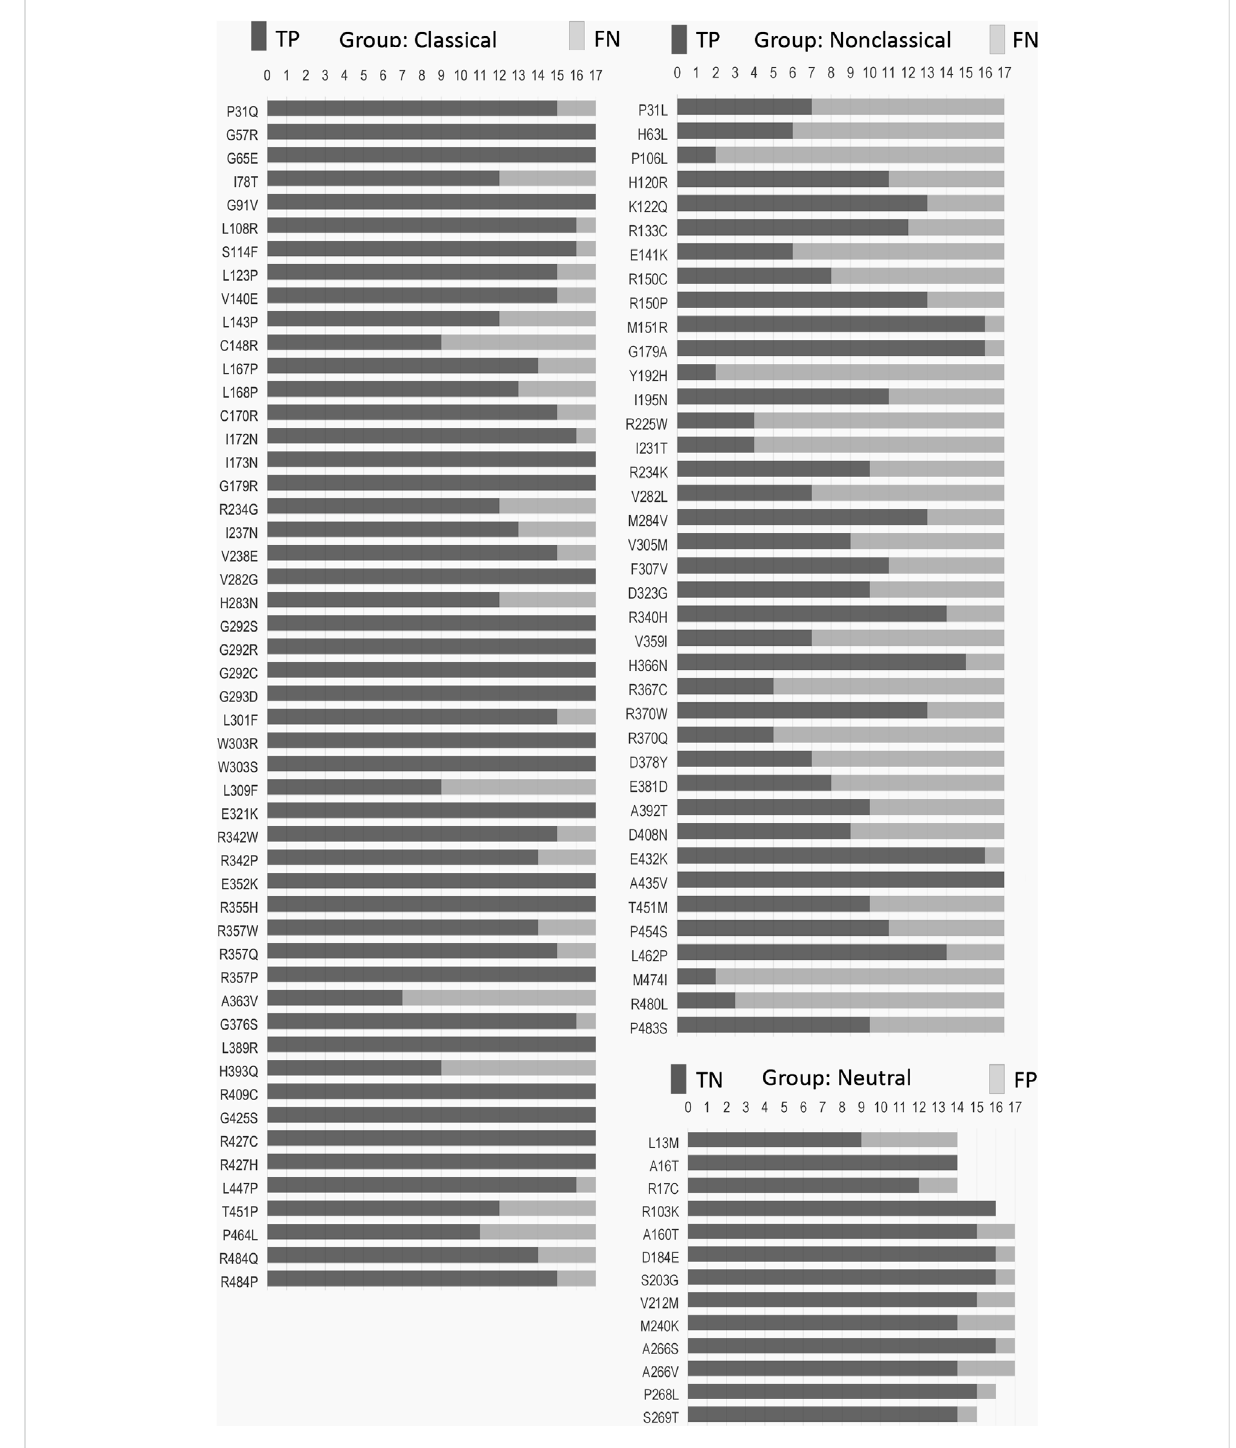
FIGURE 2 Frequency of hit and miss obtained for each SNV by mutation group. Each SNV (vertical list) was analyzed by seventeen predictors (horizontal measurement) performed with the default setting for missense mutation. Please, refer to Supplementary Table S2 – S4 for details. TP, true positive; TN, true negative; FN, false negative; FP, false